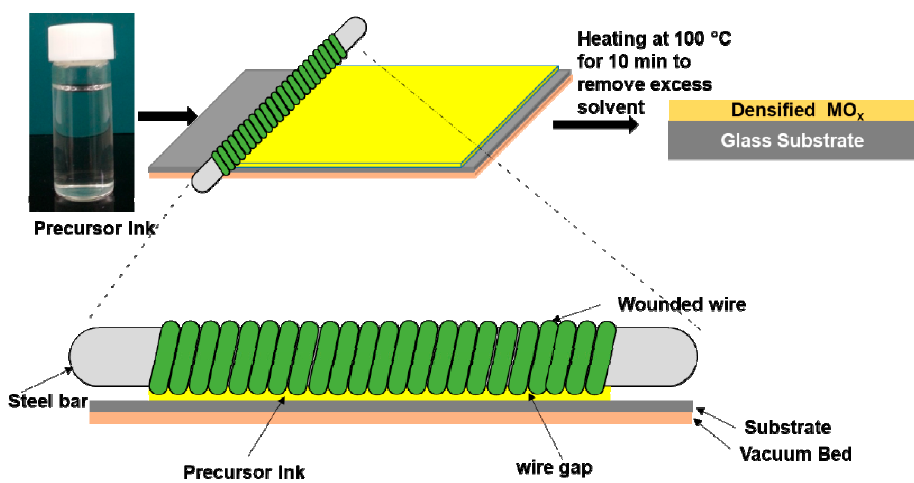
Figure 9. Schematic of wire ‐ bar coating process.